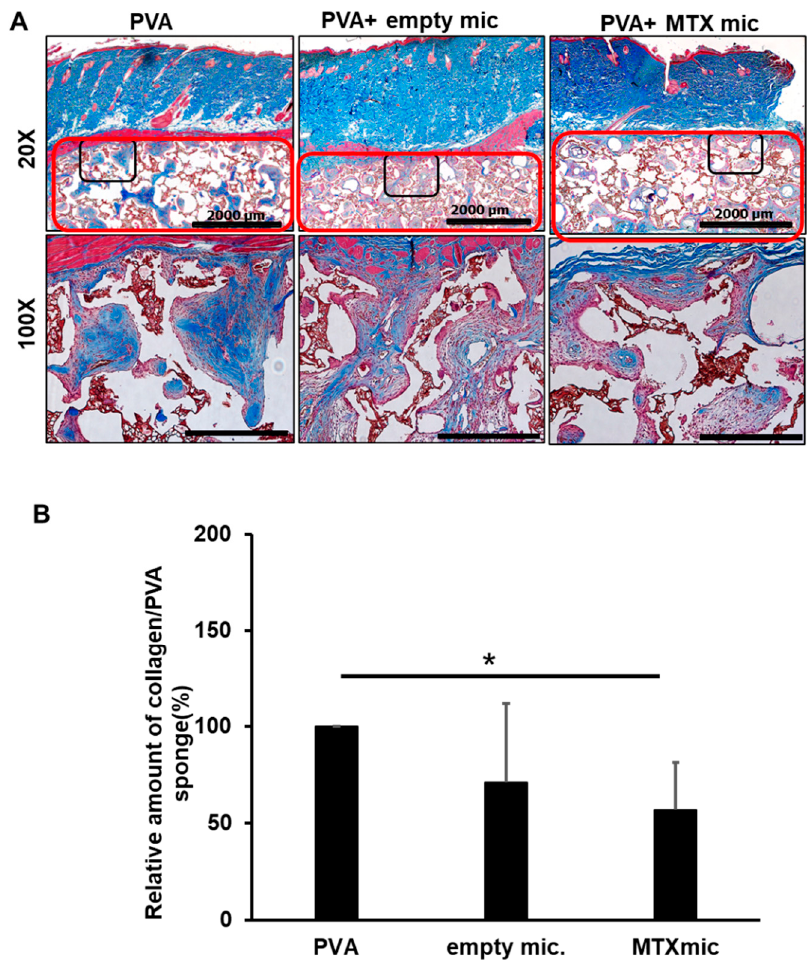
Figure 6. Collagen deposition in the PVA sponges after 62 days. ( A ) There was less collagen deposition in PVA + MTX microspheres compared to PVA alone and PVA+ empty microspheres (Reflected as less blue color in areas marked by red drawing, Masson’s trichrome staining). Scale bar = 2 mm at 20 and 500 μ m at 100× magnification. ( B ) Quantification of the collagen showed that MTX containing microspheres significantly decreased collagen deposition in PVA+MTX microspheres in comparison with PVA alone samples. n = 3, * Statistical significance, p < 0.05 .